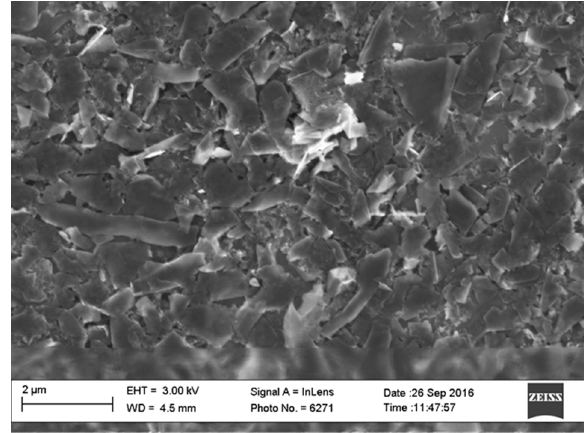
Figure 2. SEM image of the pristine grapheme.